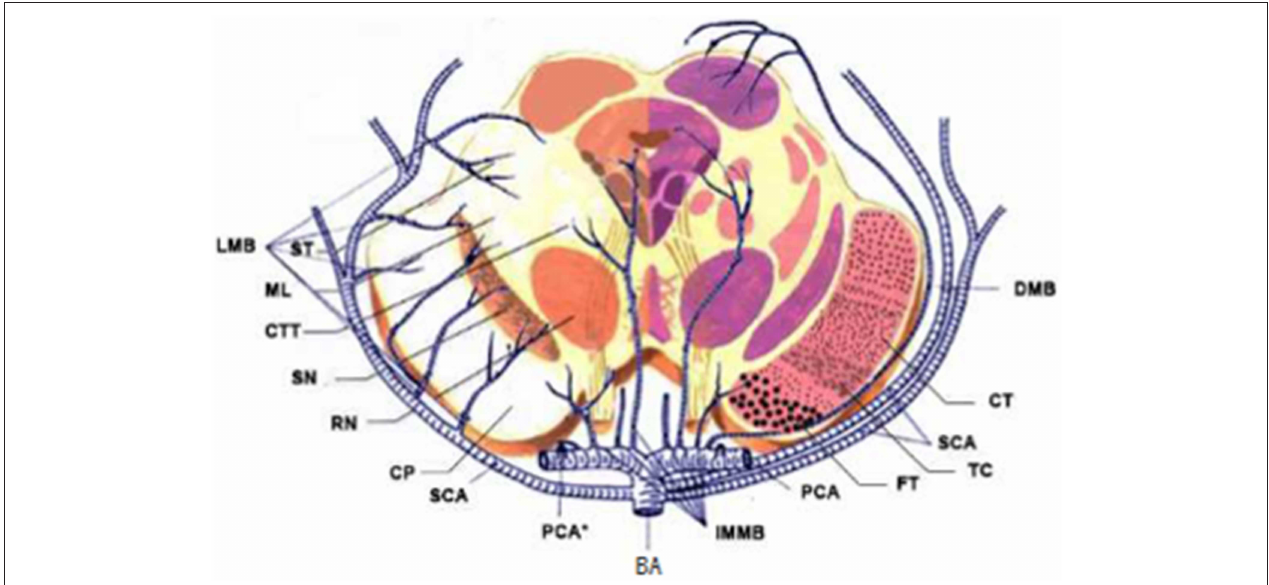
FIGURE 2 | Diagrams of the blood supply of the midbrain. LMB, Lateral Mesencephalic Branches; ST, Spinoreticular Tract; ML, Medial Lemniscus; CTT, Central Tegmental Tract; SN, Substantia Nigra; RN, Red Nucleus; CP, Cerebral Peduncular; SCA, Superior Cerebellar Artery; IMMB, Inferior medial Mesencephalic Branch; FT, Frontopontine Tract; TC, Tractus Corticobulbrais; CT, Corticospinal Tract; DMB, Dorsal Mesencephalic Branch.